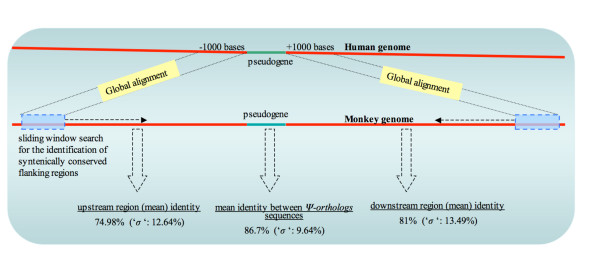
A schematic representation of the procedure for identifying syntenic noncoding (flanking) regions. Flanking regions (10000 nts) are scanned in a sliding window, equal to the length of conceptual human pseudogene transcript), by globally aligning it to the upstream/downstream regions of the human pseudogene. The best scoring window is identified, which corresponds to the syntenic (flanking) region in the monkey genome.